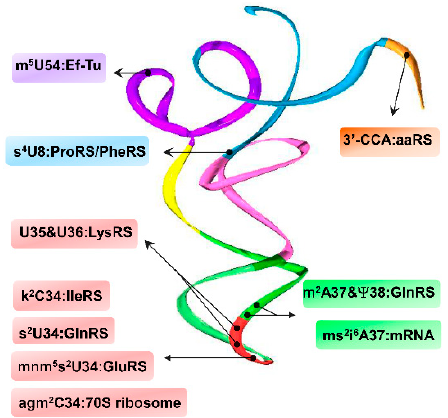
Figure 2. Modifications throughout the tRNA structure are important recognition elements for interaction with a variety of partners in translation. The tRNA structure (PDB 1u0b) shows domains color coded in accordance with Figure 1. m 5 U54 confers binding with T. aquaticus Ef-Tu [19]; s 4 U8 is necessary for structural stability impacting interactions with E. coli PheRS and ProRS [20]; U35 / U36, along with mnm 5 s 2 U34, are major identity elements for E. coli LysRS binding [17]; agm 2 C34 interacts with the T. thermophilus 70S ribosome [15]; k 2 C34 is required for codon discrimination by IleRS in E. coli and B. subtilis [14]; s 2 U34, m 2 A37, and ψ 38 are required for E. coli GlnRS substrate recognition and aminoacylation e ffi ciency [16,18]; ms 2 i 6 A37 directly interacts with cognate mRNA bases in E, P and A sites of the ribosome [8]; all aaRSs require 3 (cid:48) -CCA moiety for tRNA charging